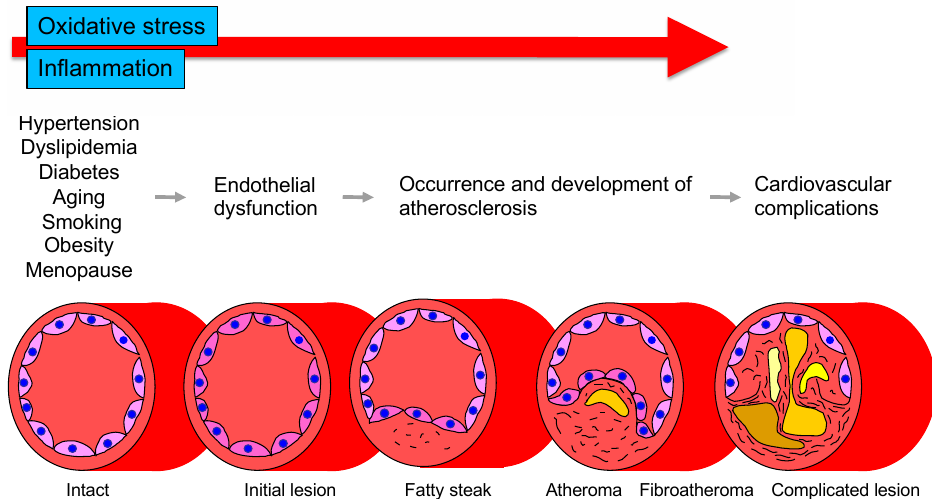
Figure 1. Roles of oxidative stress and inflammation in the process of endothelial dysfunction-related disease.